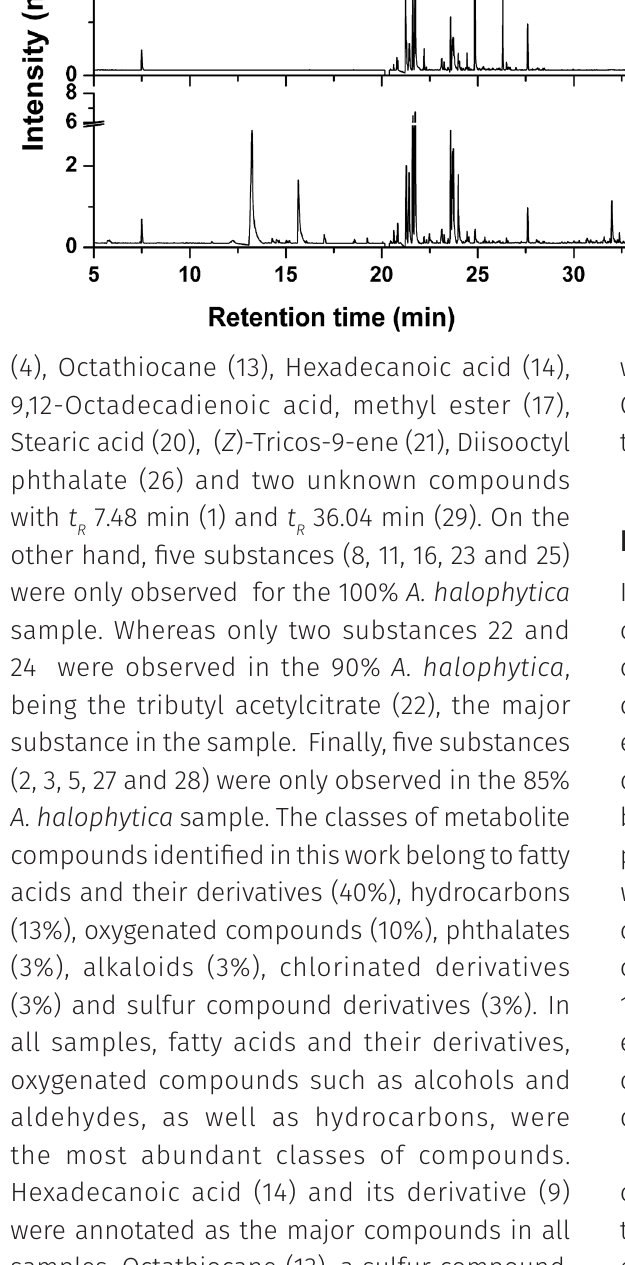
Figure 4. Chemical profiles of extracts of cyanobacteria obtained through GC-MS. (a) 100% of A. halophytica, (b) 90% of A. halophytica and (c) 85% of A.